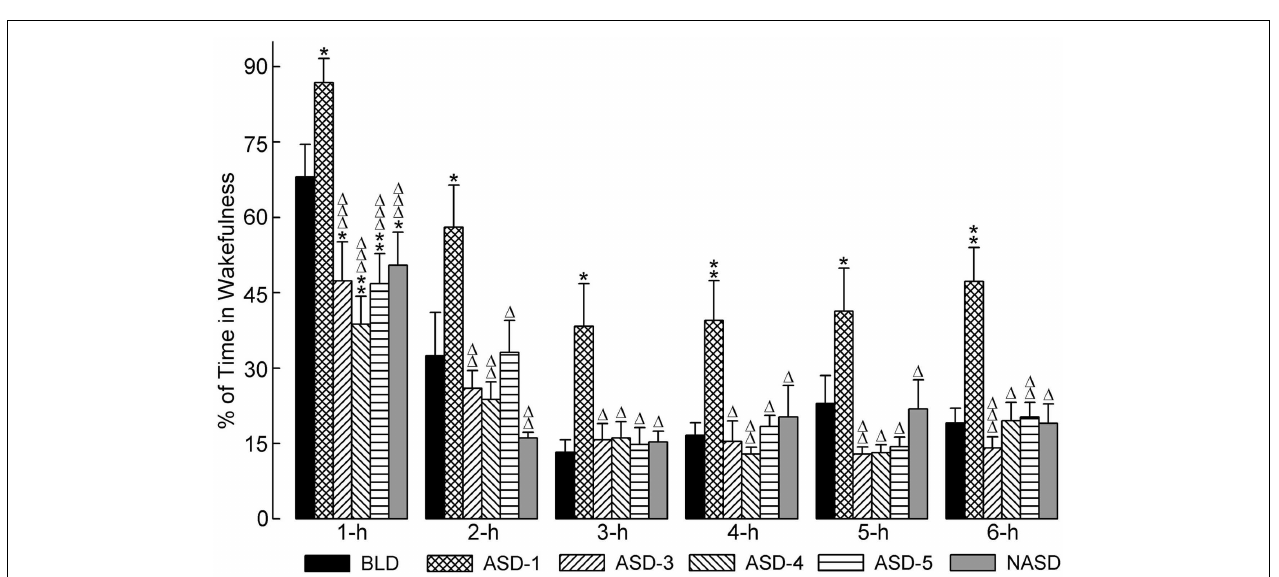
exposure (ASD-1), day 3 of AS exposure (ASD-3), day 4 of AS exposure (ASD-4), day 5 of AS exposure (ASD-5), and no exposure to AS day (NASD). *Represents a significant difference from BLD: * p < 0.05, ** p < 0.01, *** p < 0.001. ∆ represents a significant difference from ASD-1: ∆ p < 0.05, ∆∆ p < 0.01, ∆∆∆ p < 0.001.